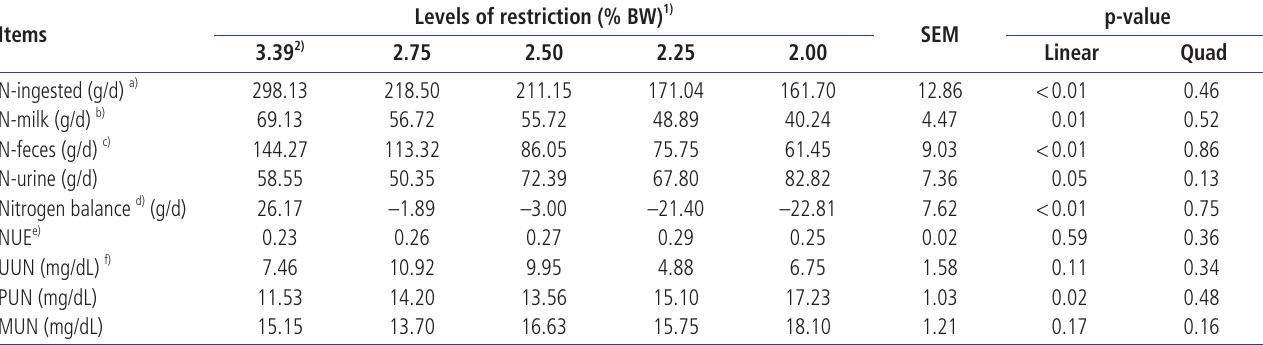
Table 3. Balance and efficiency of nitrogen use in crossbred F1 Holstein/Zebu cows under quantitative feed restriction in the middle third of lactation Items